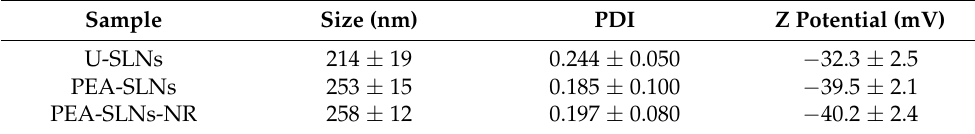
Table 1. Size, PDI, and Z-potential values of U-SLNs and PEA-SLNs. Mean values ±